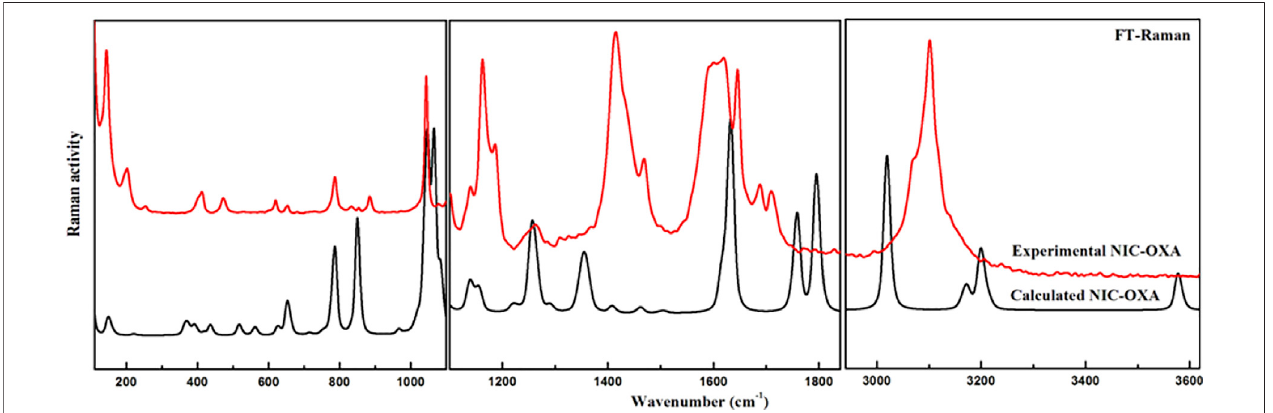
FIGURE 3 | Experimental and calculated FT – Raman spectra of NIC – OXA salt in the region of 400 – 3,620 cm − 1 . FT, Fourier transform; NIC – OXA, nicotinamide – oxalic acid.